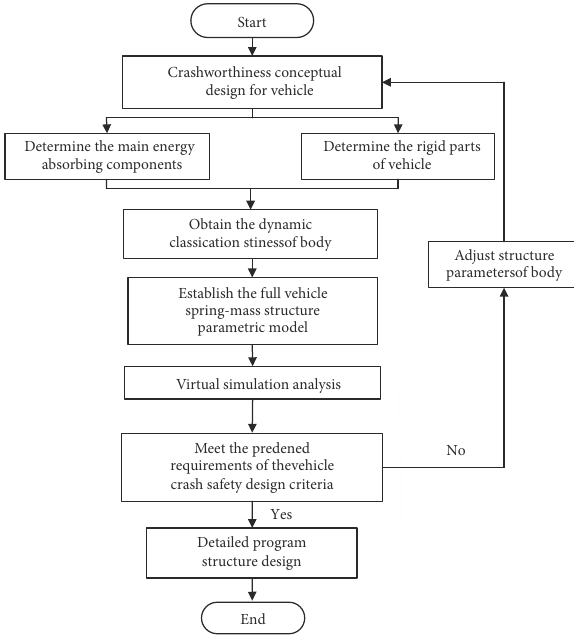
Figure 23. Conceptual design flow for vehicle